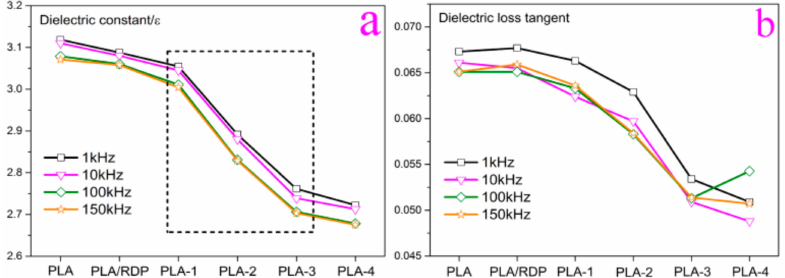
Figure 8. Dielectric permittivity ( a ) and dielectric loss tangent ( b ) with the content of